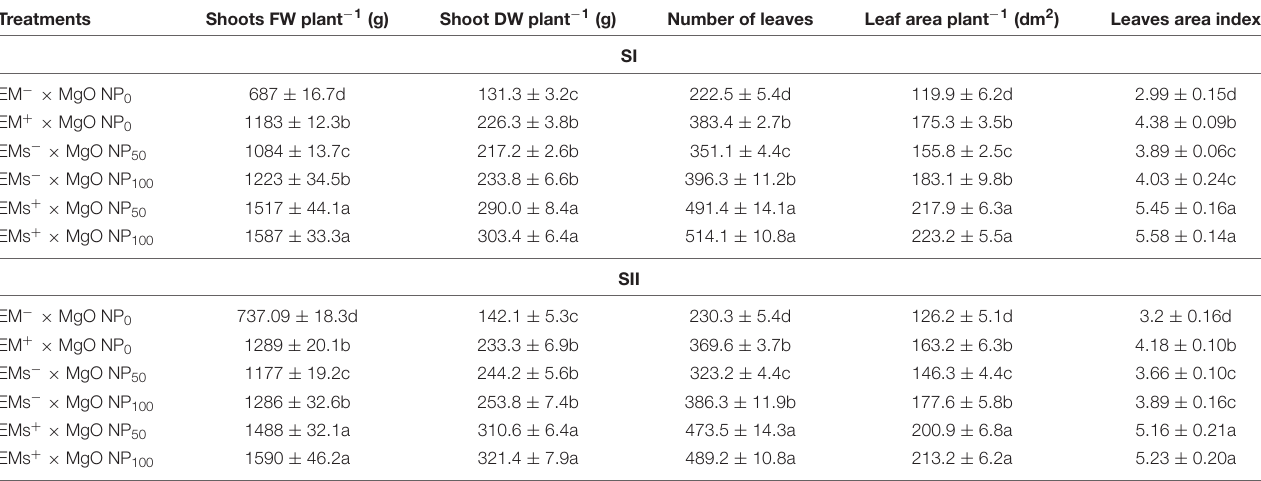
TABLE 2 | Effect of foliar application with magnesium oxide (MgO) nanoparticles (MgO-NP) and effective microorganisms (EMs) on growth attributes of sweet potato ( Ipomoea batatas L.) grown in salt affected soil in 2020 (SI) and 2021 (SII) seasons. Treatments